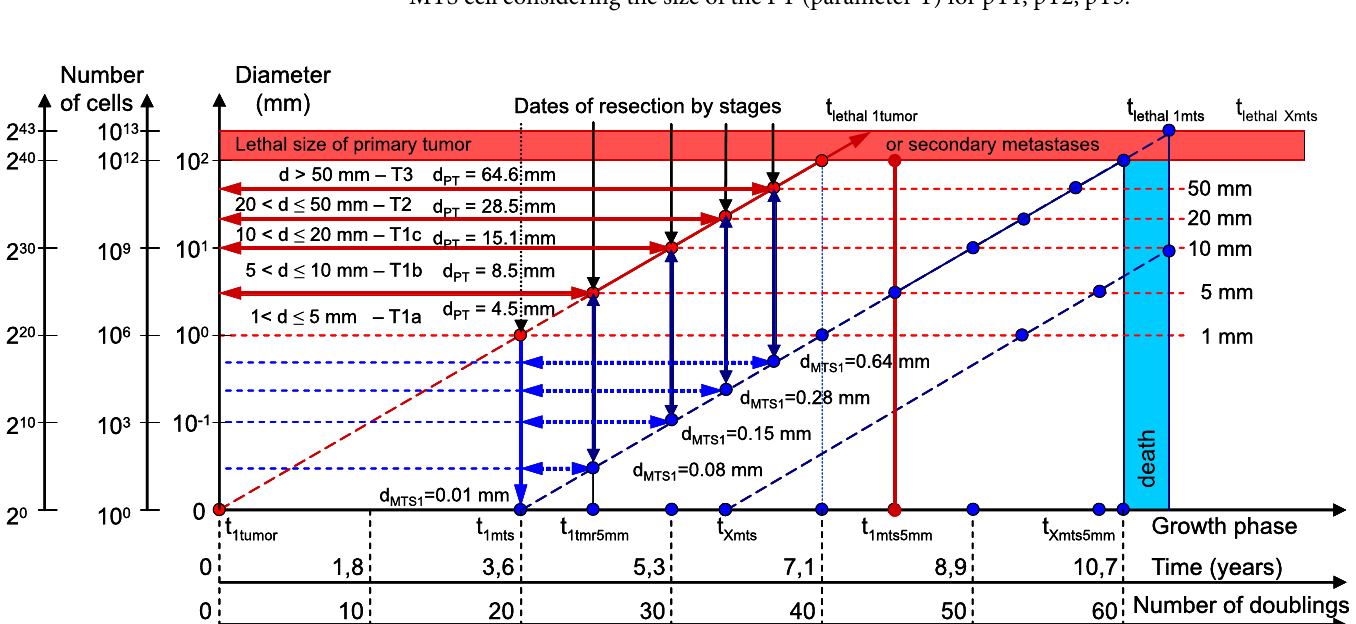
PLOS ONE | https://doi.org/10.1371/journal.pone.0200148 July 6,